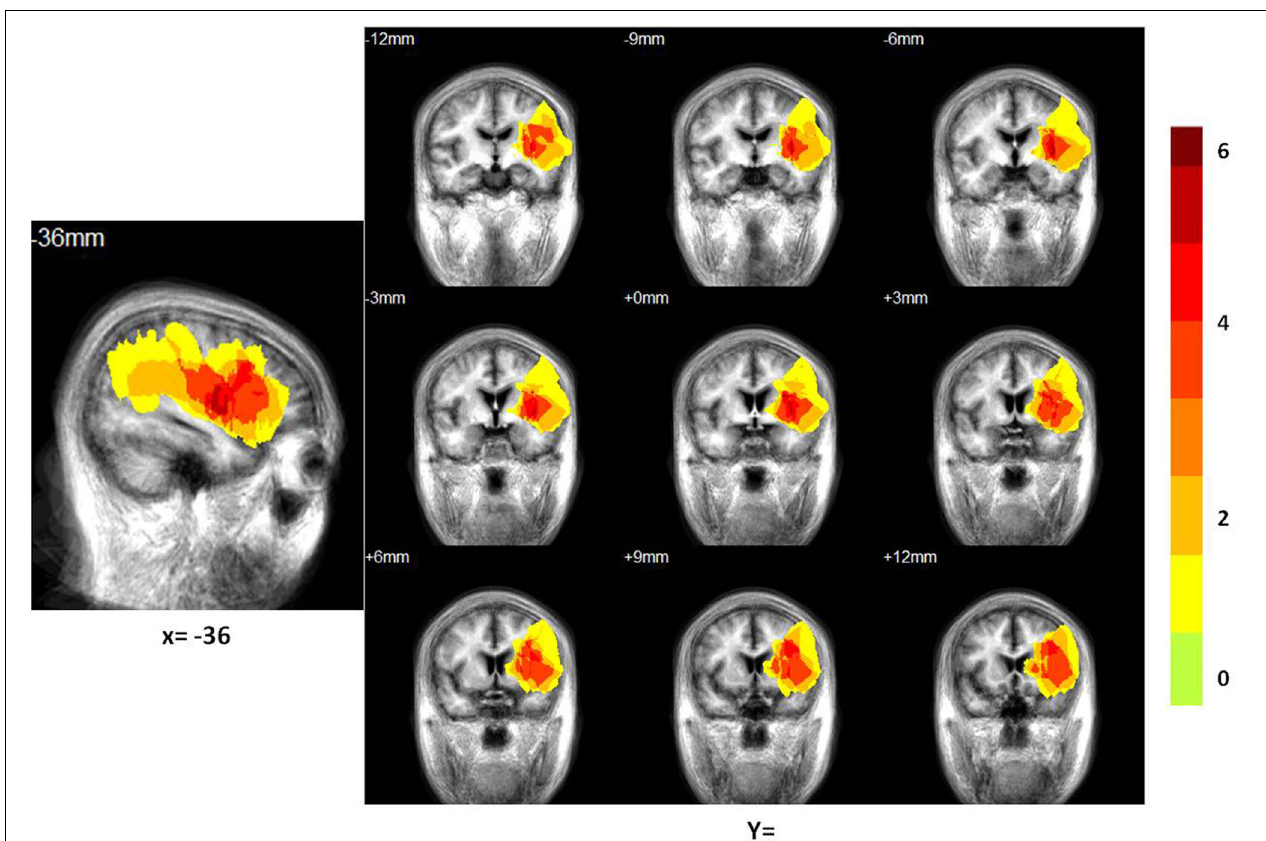
FIGURE 2 | Distribution of the lesion areas of all patients with aphasia, on the average patients’ structure brain template. The intensity scale refers to the maximum number of patients with lesions at a particular voxel.